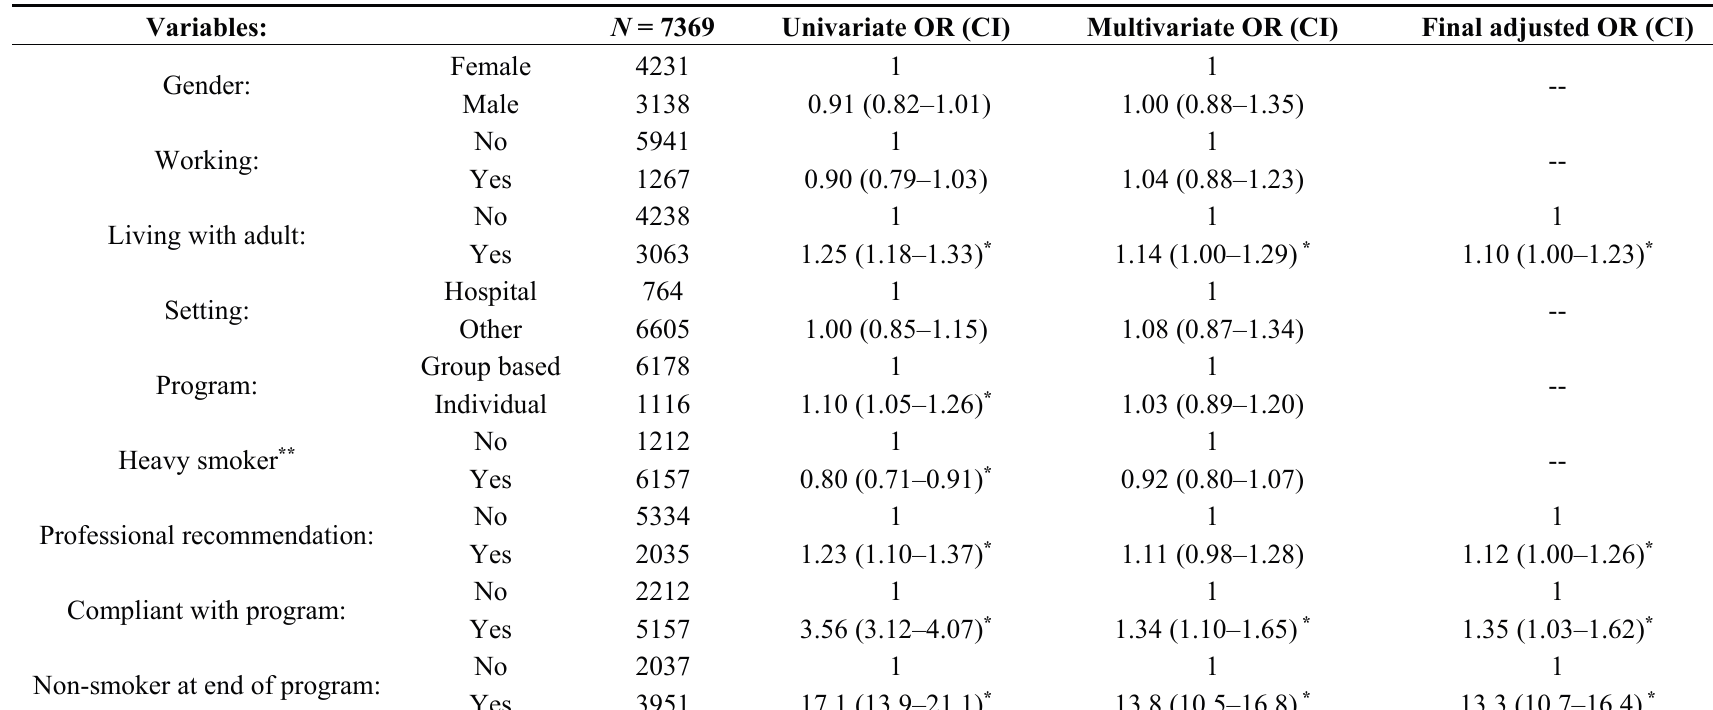
Table 3. Primary outcome: Odds Ratios with 95% confidence intervals for continuous abstinence rates after six months for participants >60 years (non-responders seen as continuous smokers) for the univariate, multivariate and the final adjusted multivariate model.